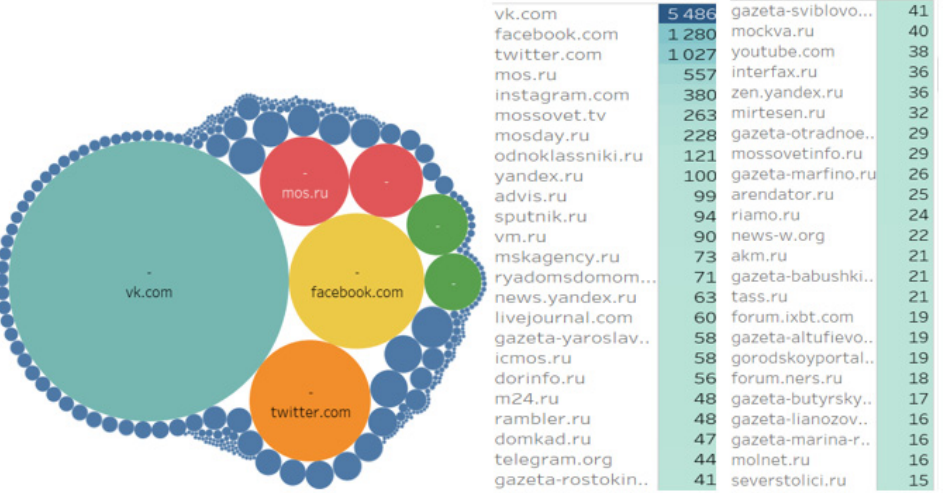
Figure 3. Rating of digital platforms by popularity among the actors.